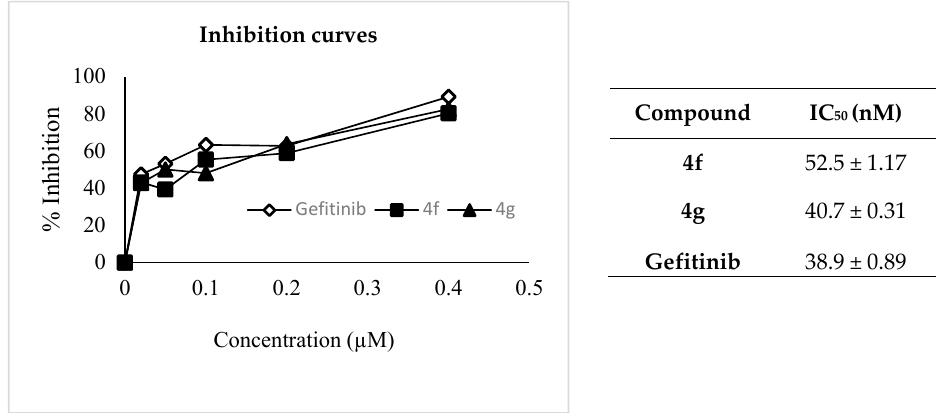
Figure 4. %Inhibition and IC 50 values (in nM) of epidermal growth factor receptor tyrosine kinase (EGFR-TK) by 4f and 4g against gefitinib.